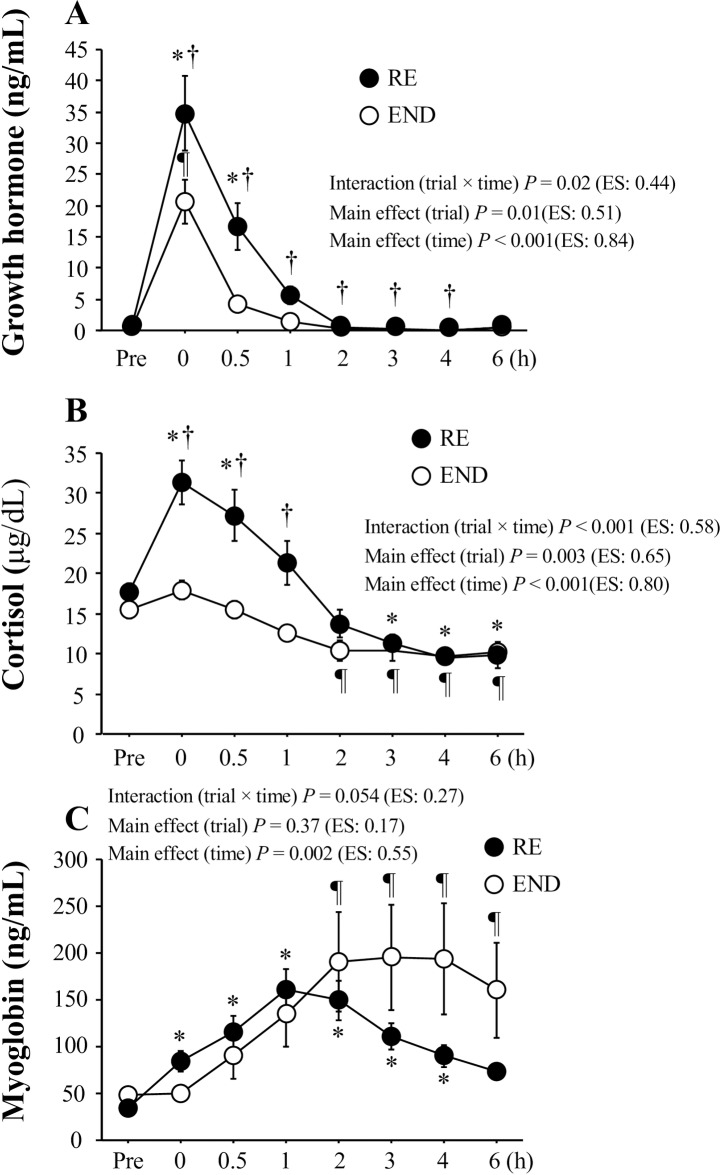
Serum GH, cortisol, and myoglobin levels before exercise and during the post-exercise period.Values present means ± SE. *P < 0.05 vs. Pre (RE). ¶ P < 0.05 vs. Pre (END). †P < 0.05 between the RE and END.